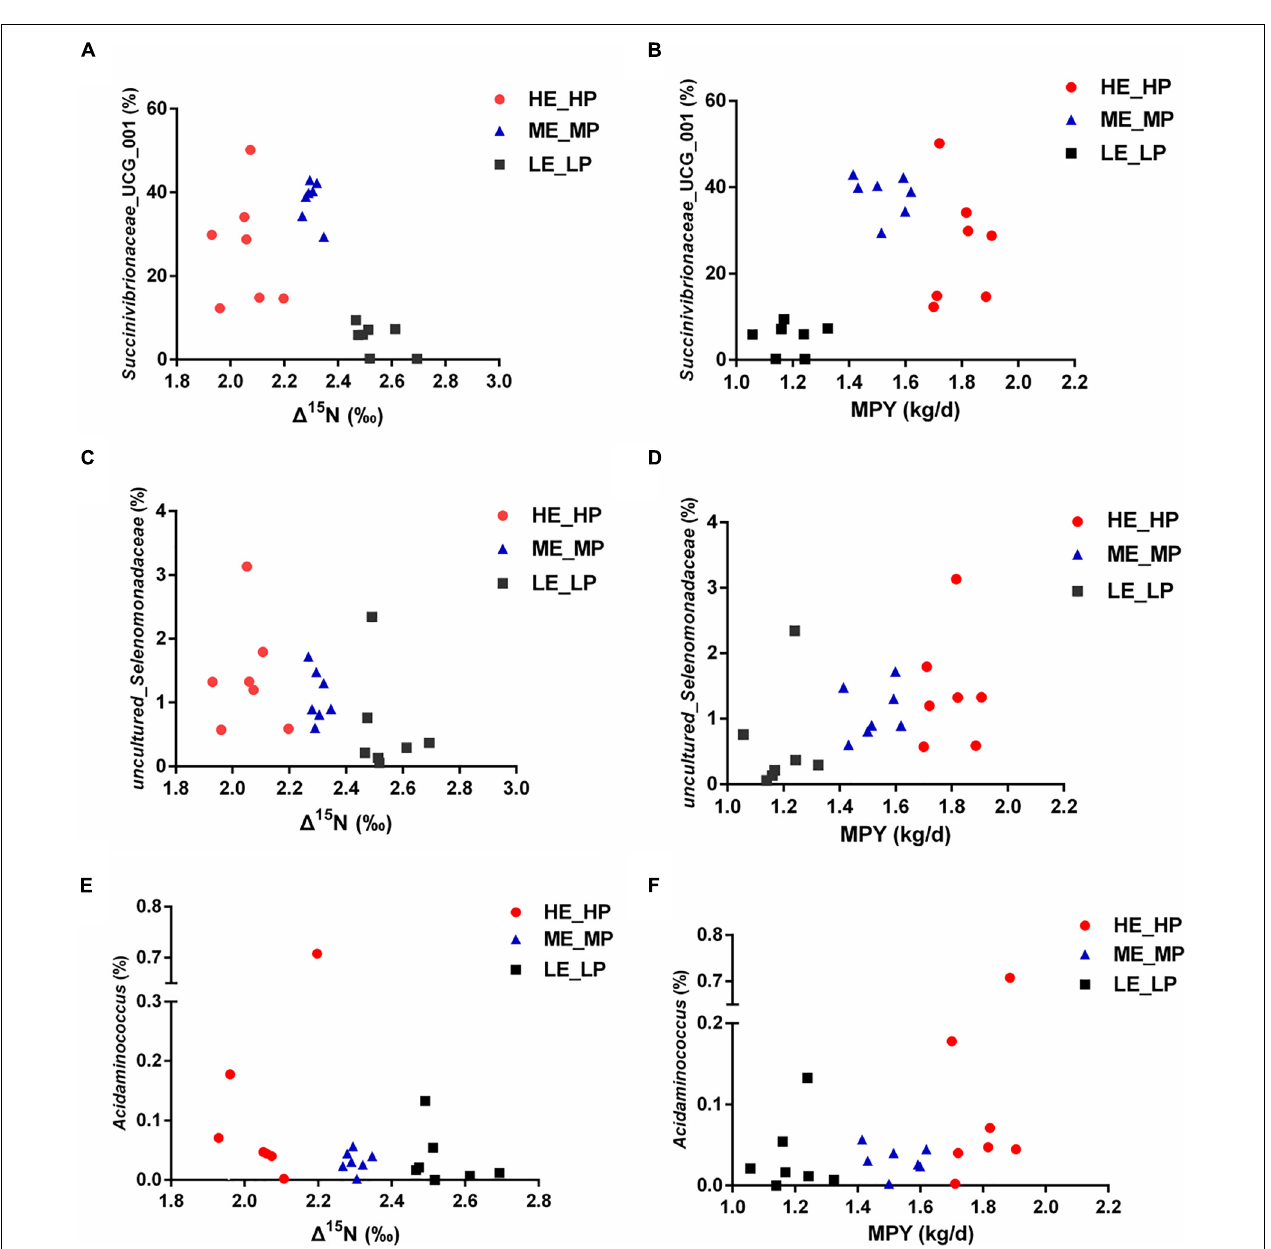
FIGURE 7 | Relative abundances of rumen bacteria and (cid:49) 15 N and milk protein yield (MPY). (A) Scatter plot of Succinivibrionaceae_UCG_001 and (cid:49) 15 N. (B) Scatter plot of Succinivibrionaceae_UCG_001 and MPY. (C) Scatter plot of uncultured_Selenomonadaceae and (cid:49) 15 N. (D) Scatter plot of uncultured_Selenomonadaceae and MPY. (E) Scatter plot of Acidaminococcus and (cid:49) 15N. (F) Scatter plot of Acidaminococcus and